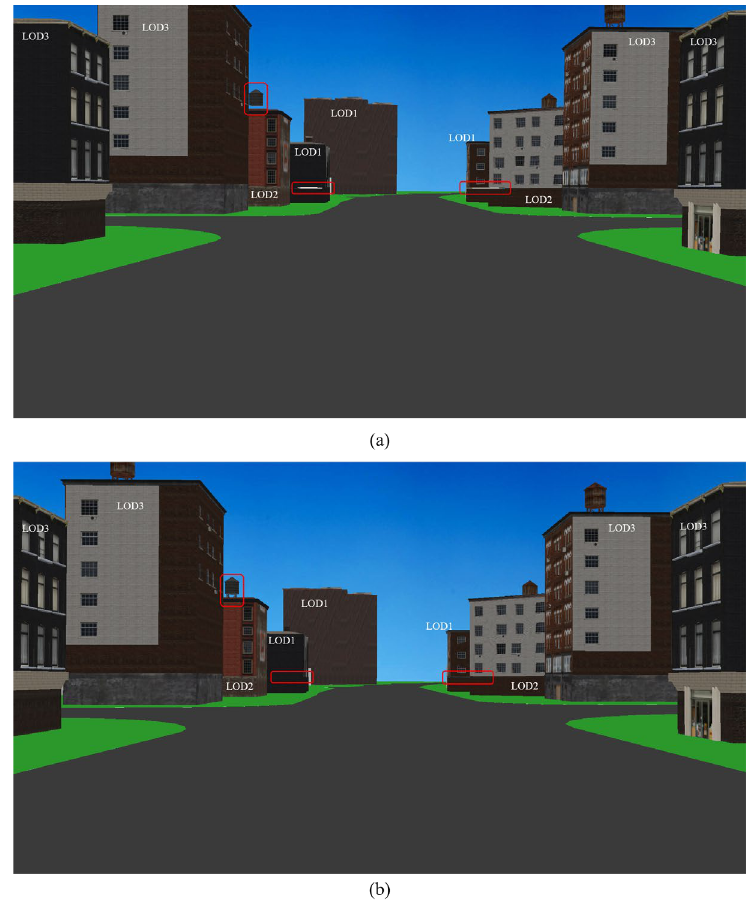
Figure 18. Visualization of 3D city scenes from the street perspective: ( a ) QEM method; ( b ) the proposed